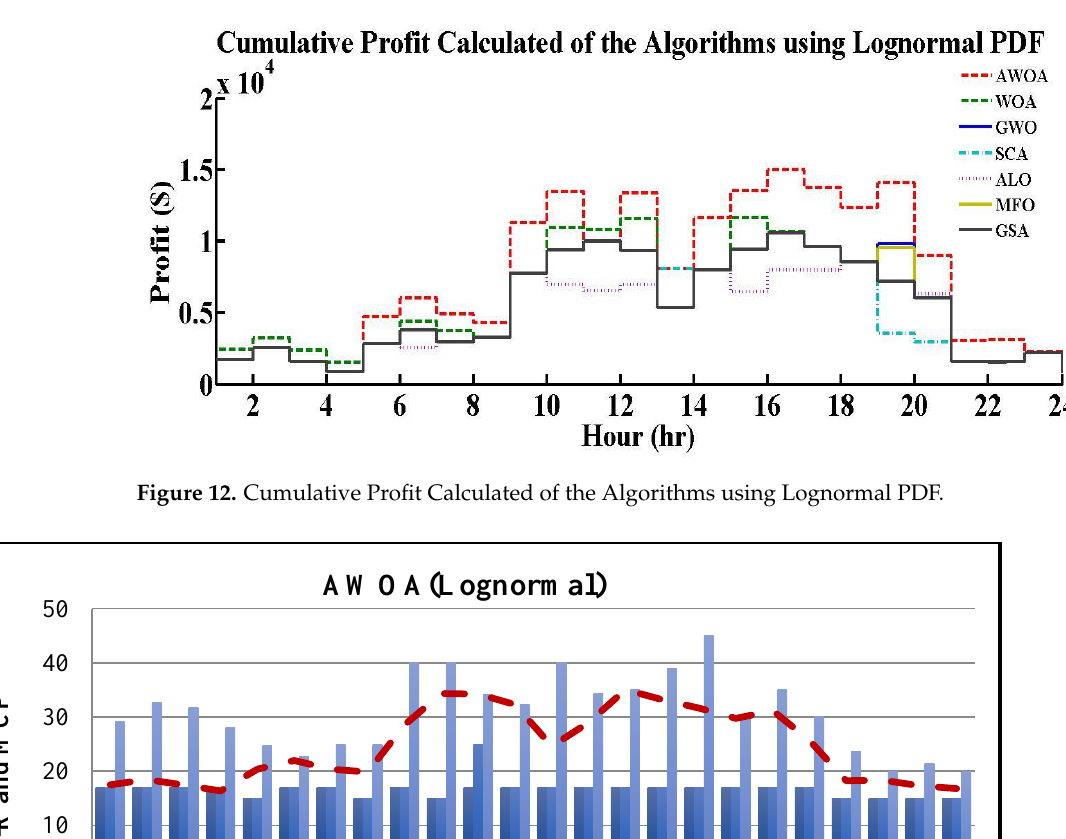
Table 10. Dispatch Obtained by Different Algorithms by using Lognormal PDF for Genco-K.